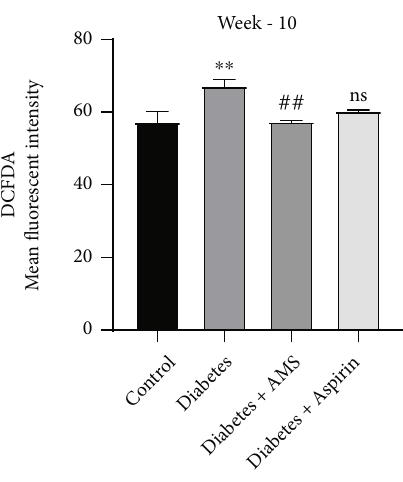
Figure 5: Comparison of ROS levels among the control, diabetes, and treatment groups. All values are represented as mean ± SEM ( N = 3 -4). ∗∗ p < 0 : 01 vs. the control; ## p < 0 : 01 vs. diabetes; ns: nonsigni fi cant.